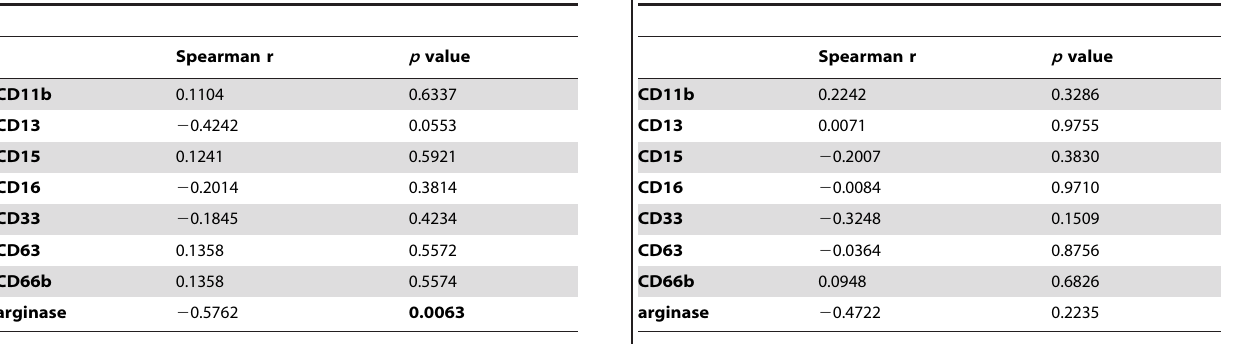
Table 5. Phenotype of LDGs.